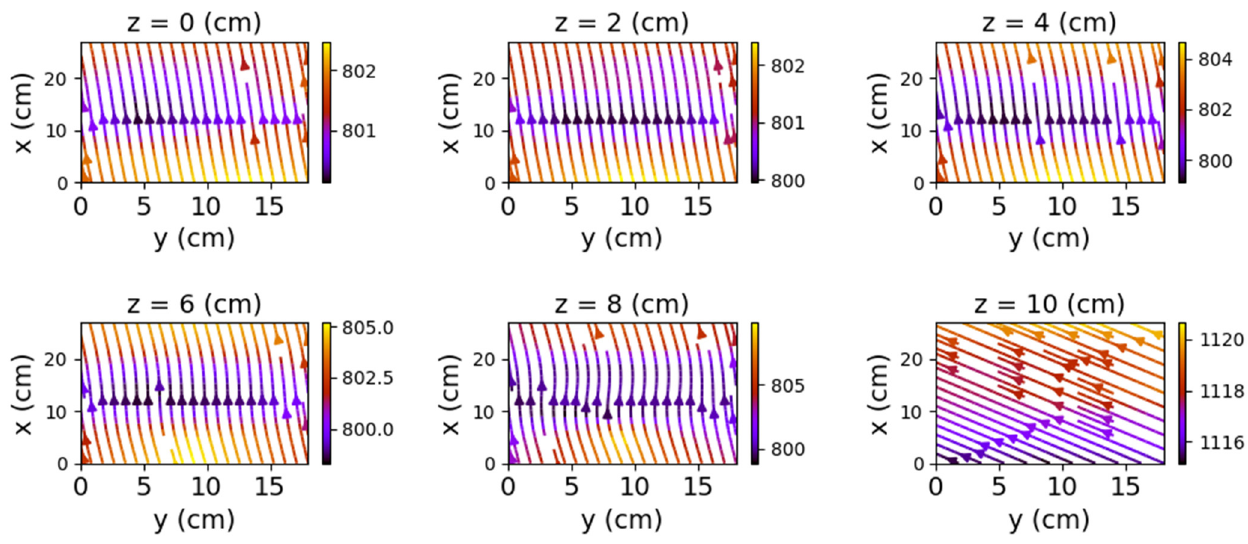
Figure 14. Field lines for x O y plane—relay with both coils powered.